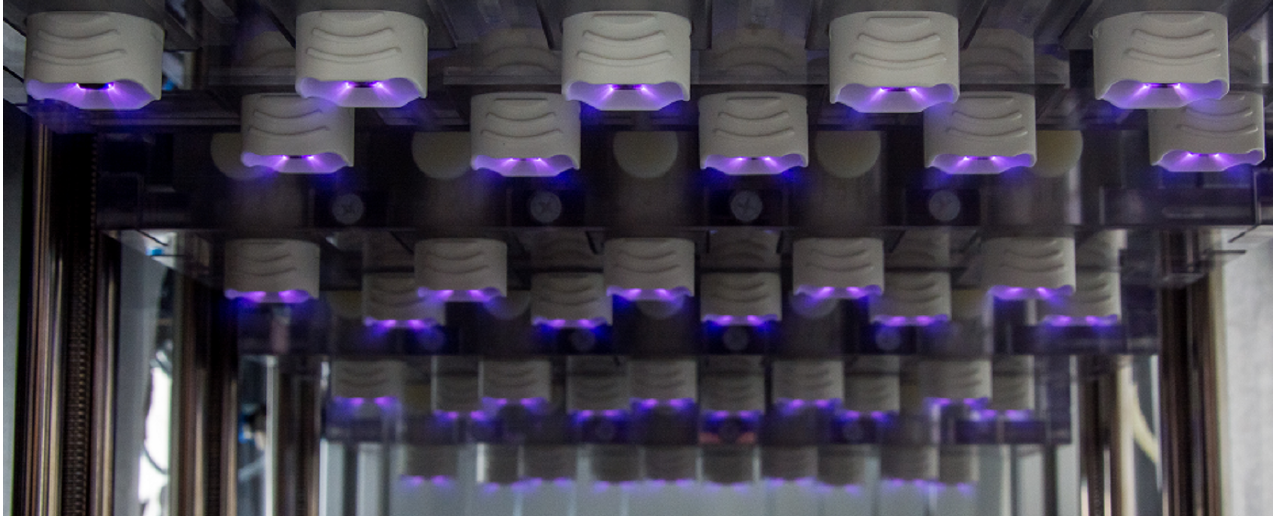
Figure 7. The plasma system consisting of 40 PCPGs organized into four units of 10 PCPG modules is shown under operation. The input power and CDA flow of each PCPG is 8.0 W and 7 SLM